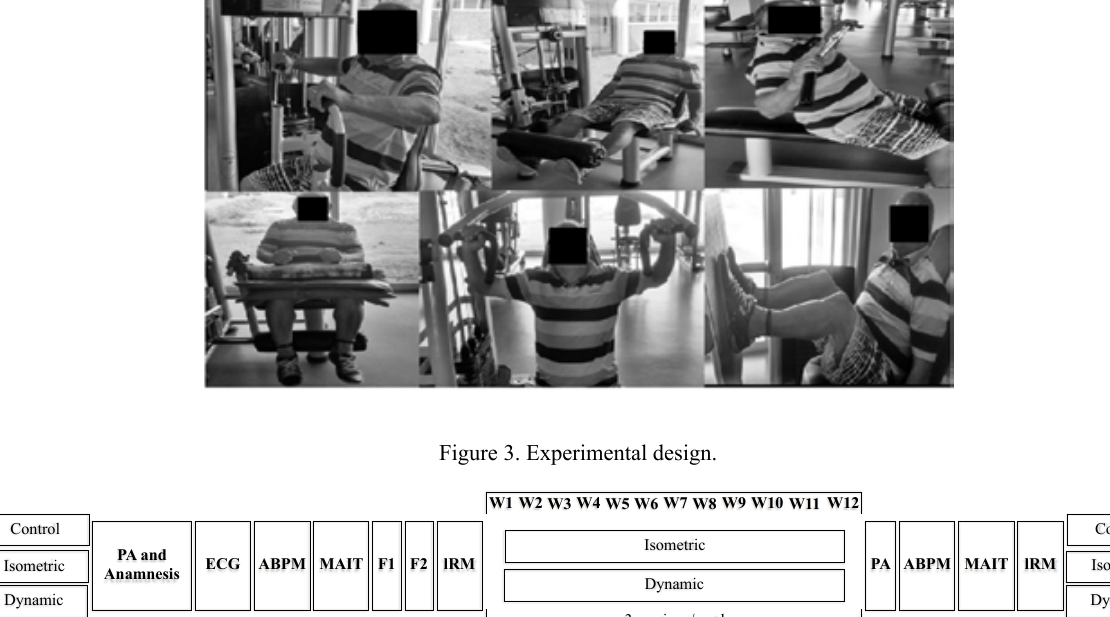
Figure 2. Exercises performed in the circuit, standardized at a single disadvantage angle to isometric training.